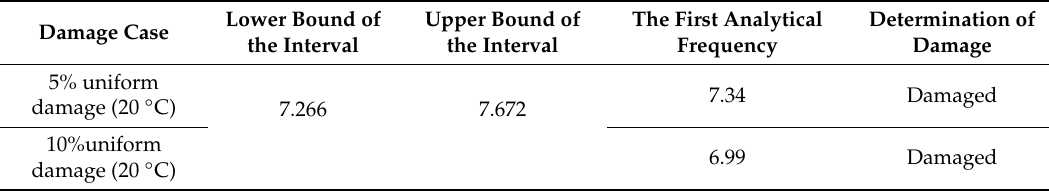
Table 4. Determination of damage using statistical